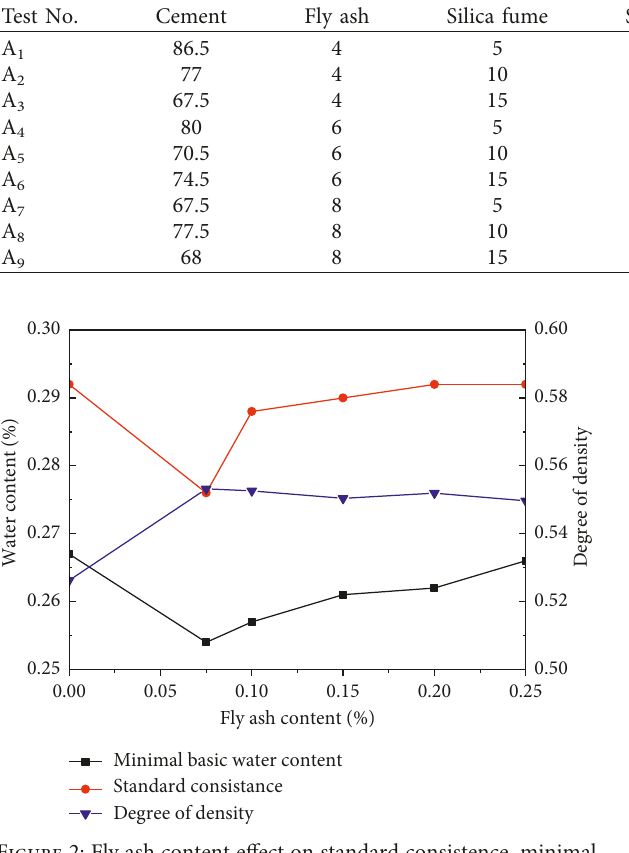
Figure 4: Silica fume on standard consistence, minimal water requirement, and stacking density.